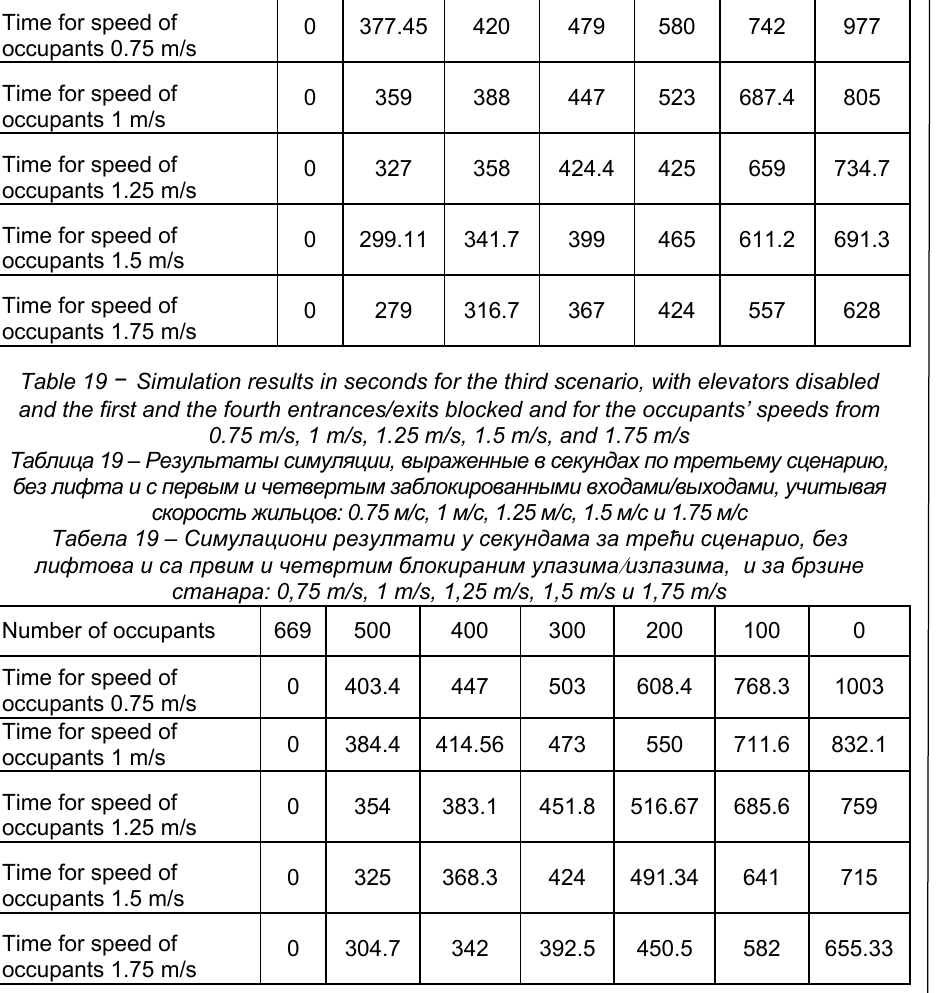
and the first and the third entrances/exits blocked and for the occupants’ speeds from